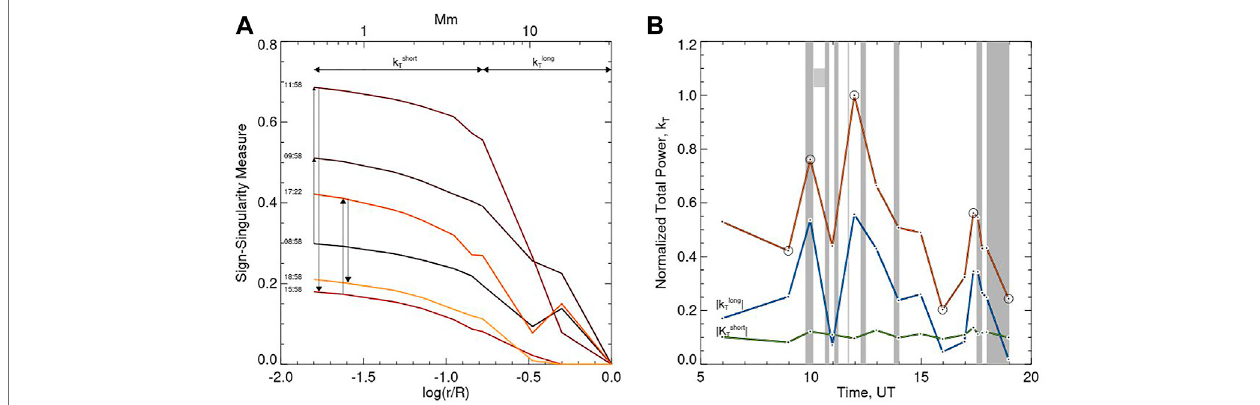
FIGURE 7 | Sign-singularity measures (A) , curves shown for selected time instances, and time variations of their parameters (B) calculated for the twist maps shown in Figure 4 . In the (A) the arrows indicate direction of the evolution of these measures, while the time stamps are shown to connect these curves to the corresponding images in Figure 4 . The two-sided arrows mark linear intervals used to calculate the cancellation exponent, k short T , and the slope of the long range end of the measure, k long T . (B) shows time variations of the total power (brown) calculated for each measure shown in the (A) , as well as the corresponding cancellation exponent ( k short T , green) and the slope ( k long T , blue). The data points indicated by circles are those that correspond to the measures in the left plot. The vertical strips indicate the start time and the duration ofAIA 17.1 nm brightenings and the X1.2 fl are (18:00 – 19:00 UT) associated with the AR fi lament and the horizontalbar between 10:07 and 10:37 UT marks the timing of a M7.2 fl are that occurred in the south-east part of the